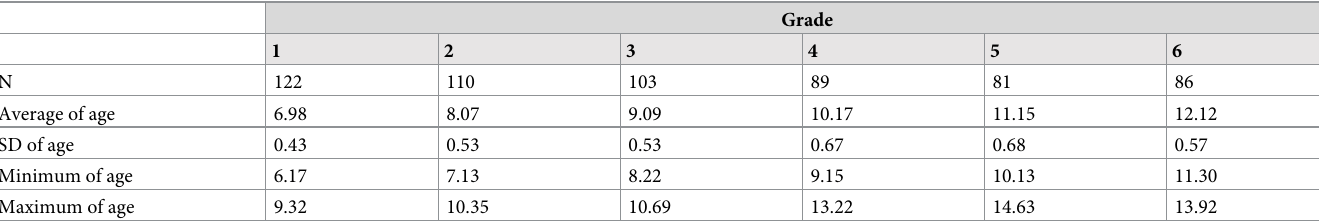
Table 6. The age range of the students in different grades.